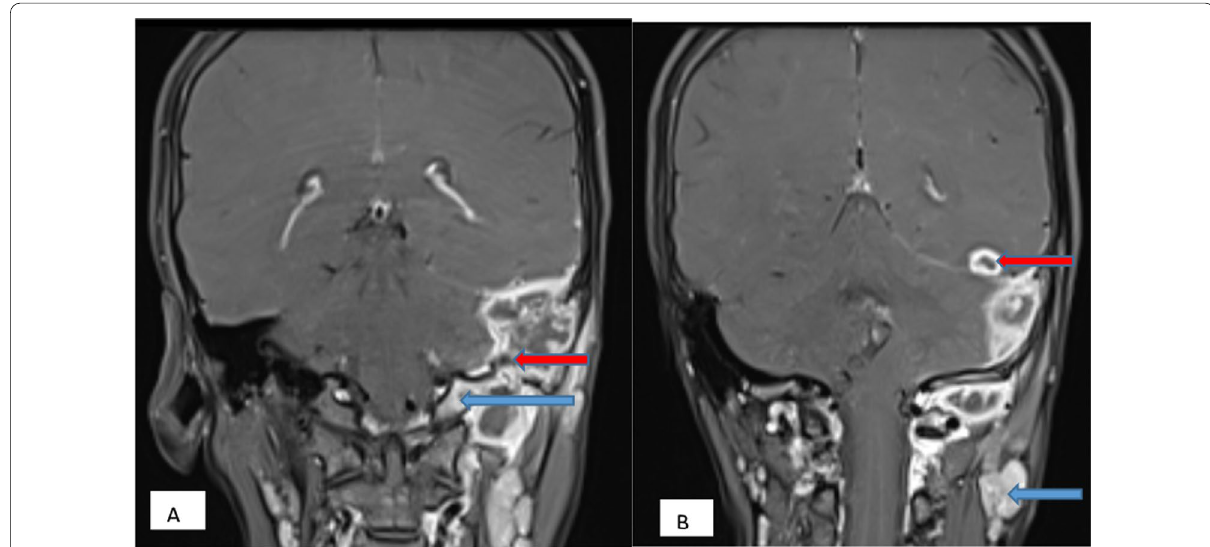
Fig. 4 Coronal post-contrast T1 fat-suppressed MR image shows: A ) peripherally enhancing soft tissue intensity lesion in left petromastoid temporal bone (red arrow) with extension in left occipital condyle (blue arrow). B ) Peripherally enhancing lesion in left temporal parenchyma abutting the tentorium cerebelli (red arrow) with homogenously enhancing enlarged cervical lymph nodes (blue arrow)